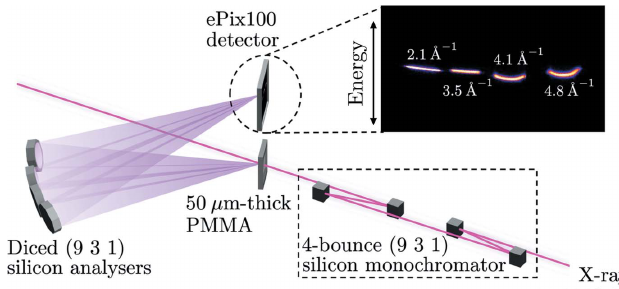
Figure 1 Schematic of the experimental setup used to perform milli-electronvolt inelastic X-ray scattering at the MEC endstation at the LCLS. X-ray pulses at 10.896 keV are first monochromated using a four-bounce (931) silicon monochromator arranged in a non-dispersive configuration and positioned at a glancing angle of incidence of 87.9 (cid:3) . Monochromatic X-ray pulses are then incident on a 50 m m-thick PMMA sample. Scattered photons are finally collected by four diced (931) silicon analysers and focused on an ePix100 detector (Carini et al. , 2016). The sample is oriented at a 22 (cid:3) angle such that the scattering vector Q is parallel to the [010] crystallographic direction at the 44 (cid:3) analyser location. The inset shows the raw data collected for each analyser. The curvature of the traces at Q = 4.1 A˚ (cid:4) 1 and Q = 4.8 A˚ (cid:4) 1 is postulated to arise from defocusing effects as these analysers could not be positioned at best